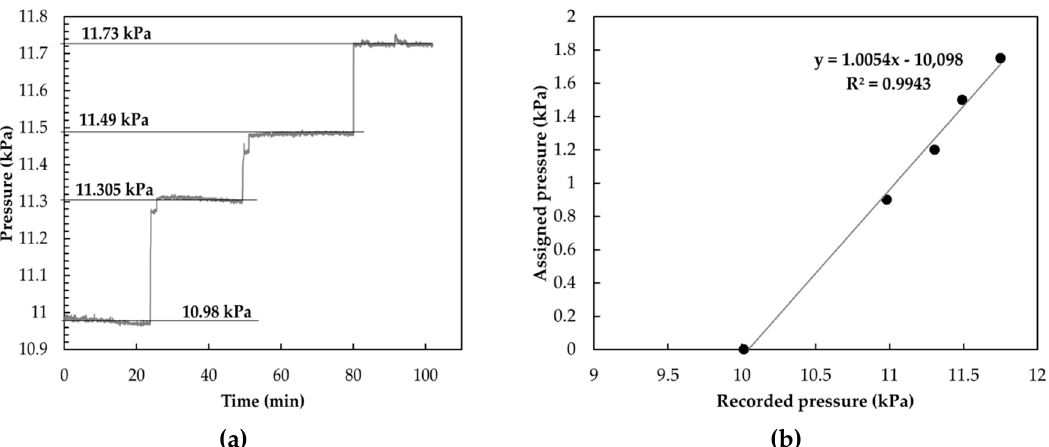
Figure 4. Example of calibration of a pressure transducer:( a ) the graph shows the recorded response, in terms of pressure values, of the device at the various pressures applied; and ( b ) the graph shows the calibration curve of the transducer used.